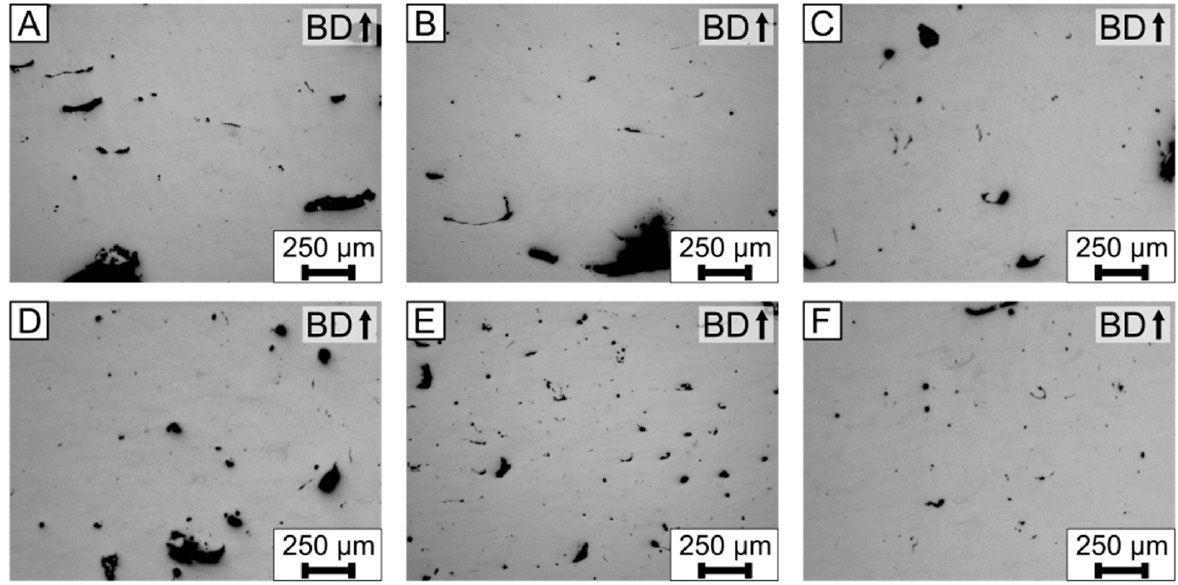
Figure 5. Light microscope images of the polished cross sections for the MOD1 +7 wt.% AlSi10Mg (Table 3). ( A – F ) Process parameters are listed in Table 2 and correspond to the letter of each cross section. The results of the density measurements, which were calculated with image processing, are listed in Table 5. Table 5. Results of the density measurements of Modification I specimens, done with image pro ‐ cessing. The process parameters used are listed in Table 2.